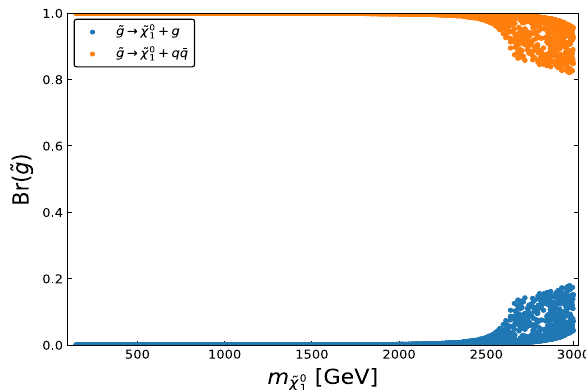
Fig. 2 The branching ratio of ˜ g in the gluino coannihilation